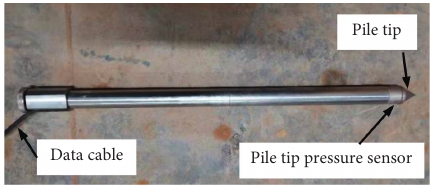
Figure 3: Physical diagram for a model pile. Table 1: Model test scheme.